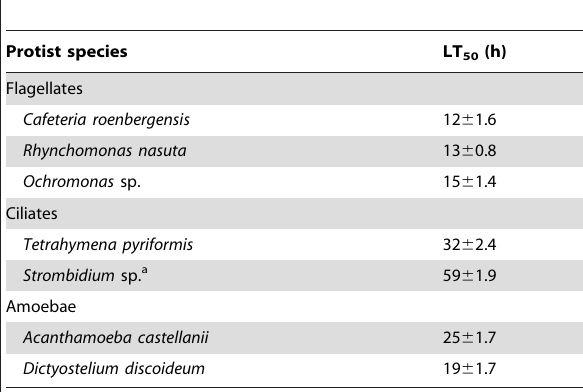
Table 2. Susceptibility of diverse protist taxa to V. parahaemolyticus